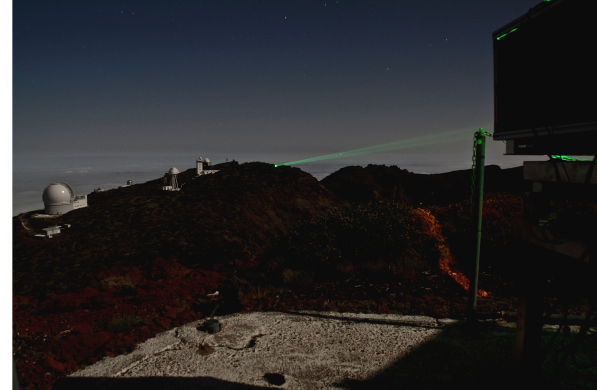
Fig. 3. The laser beam hits the mountain side about 500m away from the transmitter during collimation tests to calibrate the beam size as a function of lens (L in Fig. 2a)